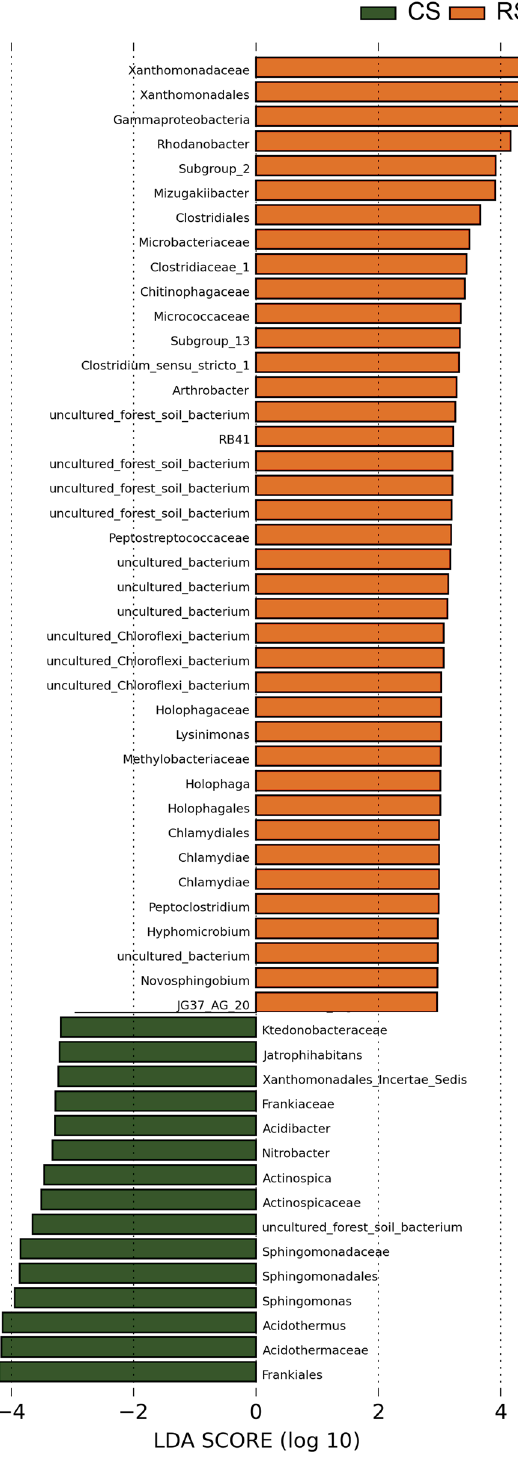
Figure 5. Differentially abundant bacterial taxa as assessed using linear discriminant analysis (LDA) with effect size measurements (LEfSe) in the 10-year post-ginseng rotation soil (RS) and soil in which no ginseng was grown (CS) before ginseng